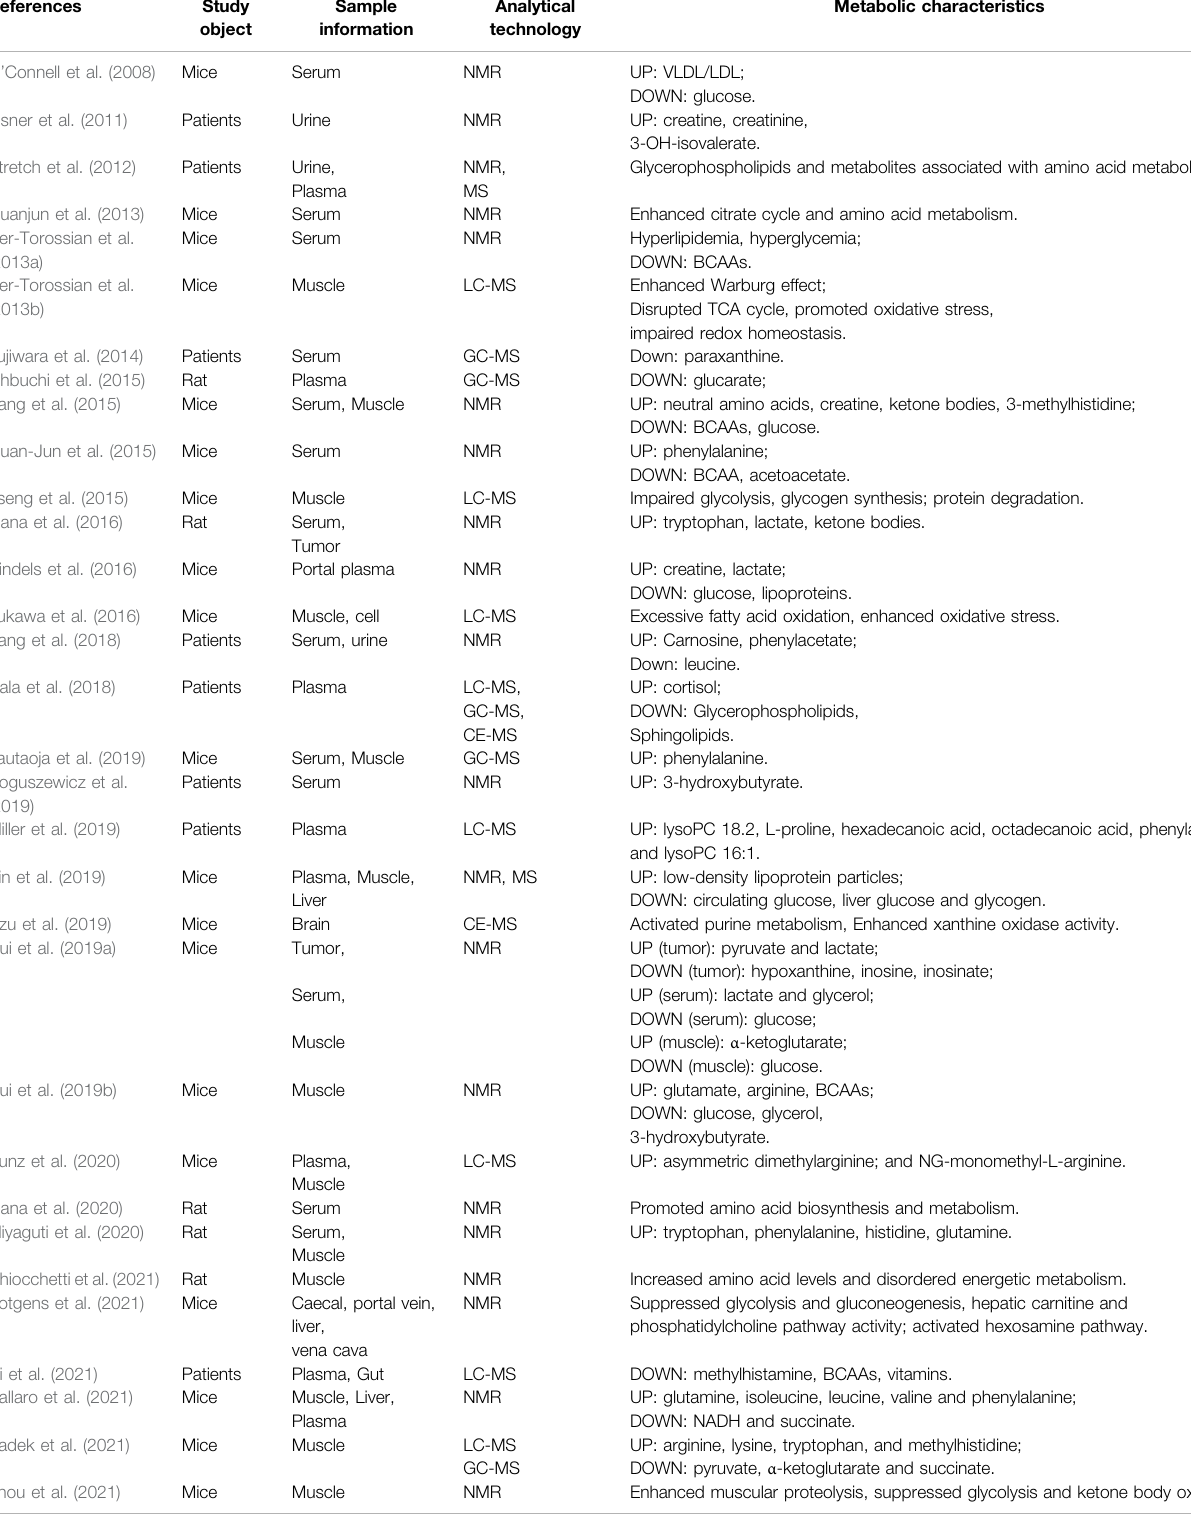
TABLE 2 | Overview of metabolic characteristics of